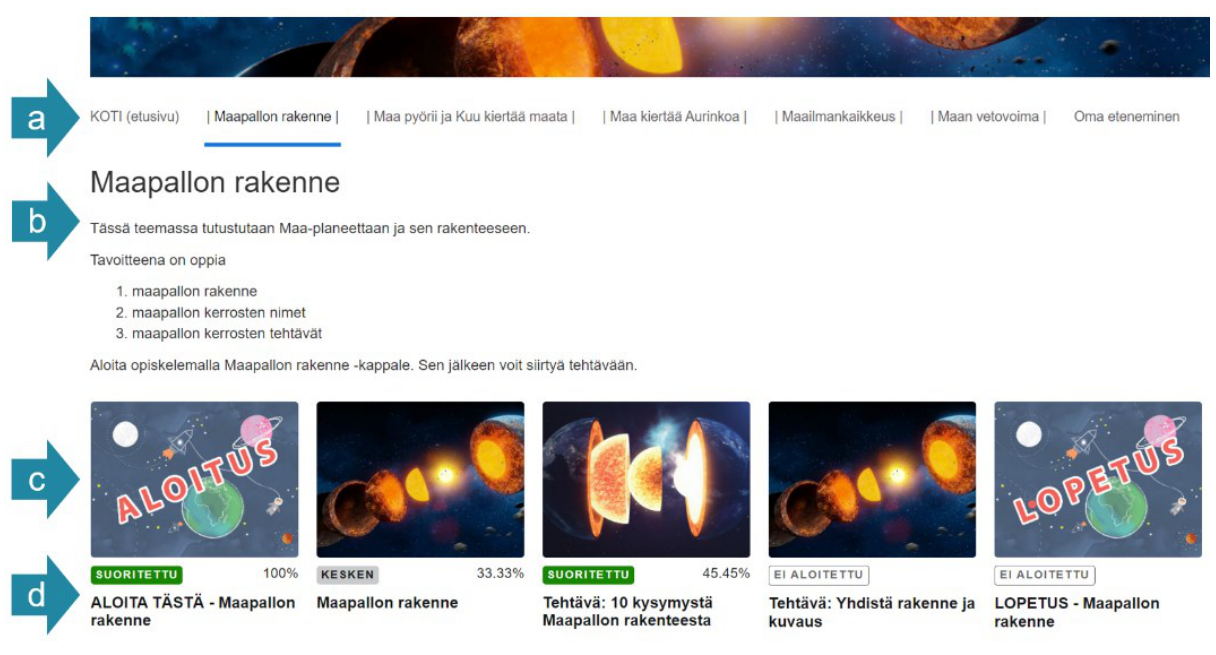
Preview of Theme 1 in the LMS, including (a) site navigation, (b) objectives, (c) chapters, and (d) completion statuses and